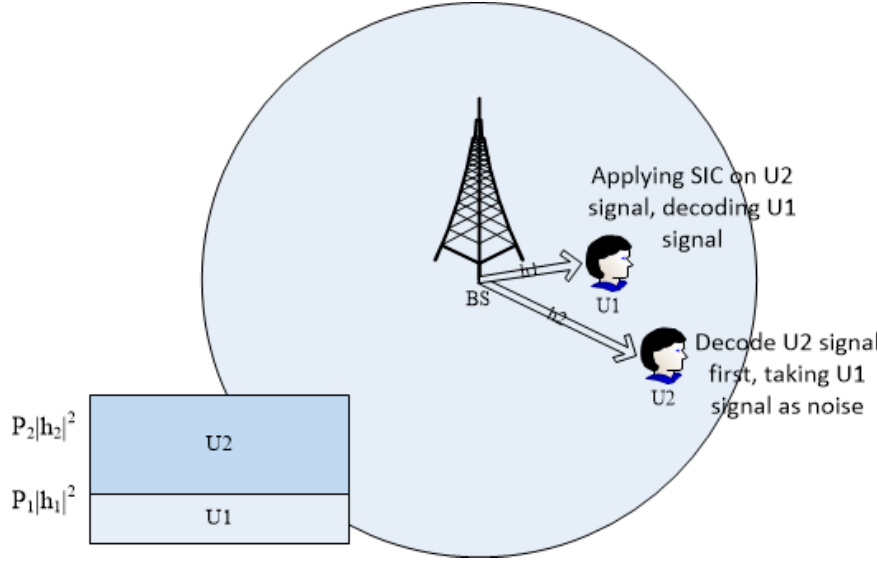
Figure 1. PD-NOMA with 2 users .